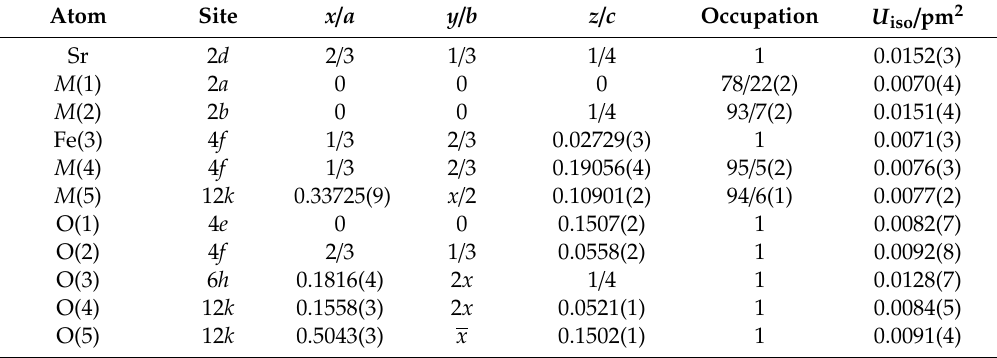
Table 3. Wycko ff sites, fractional coordinates in the asymmetric unit, occupational parameters and isotropic displacement factors for every unique ion site of crystal 2 after annealing in a